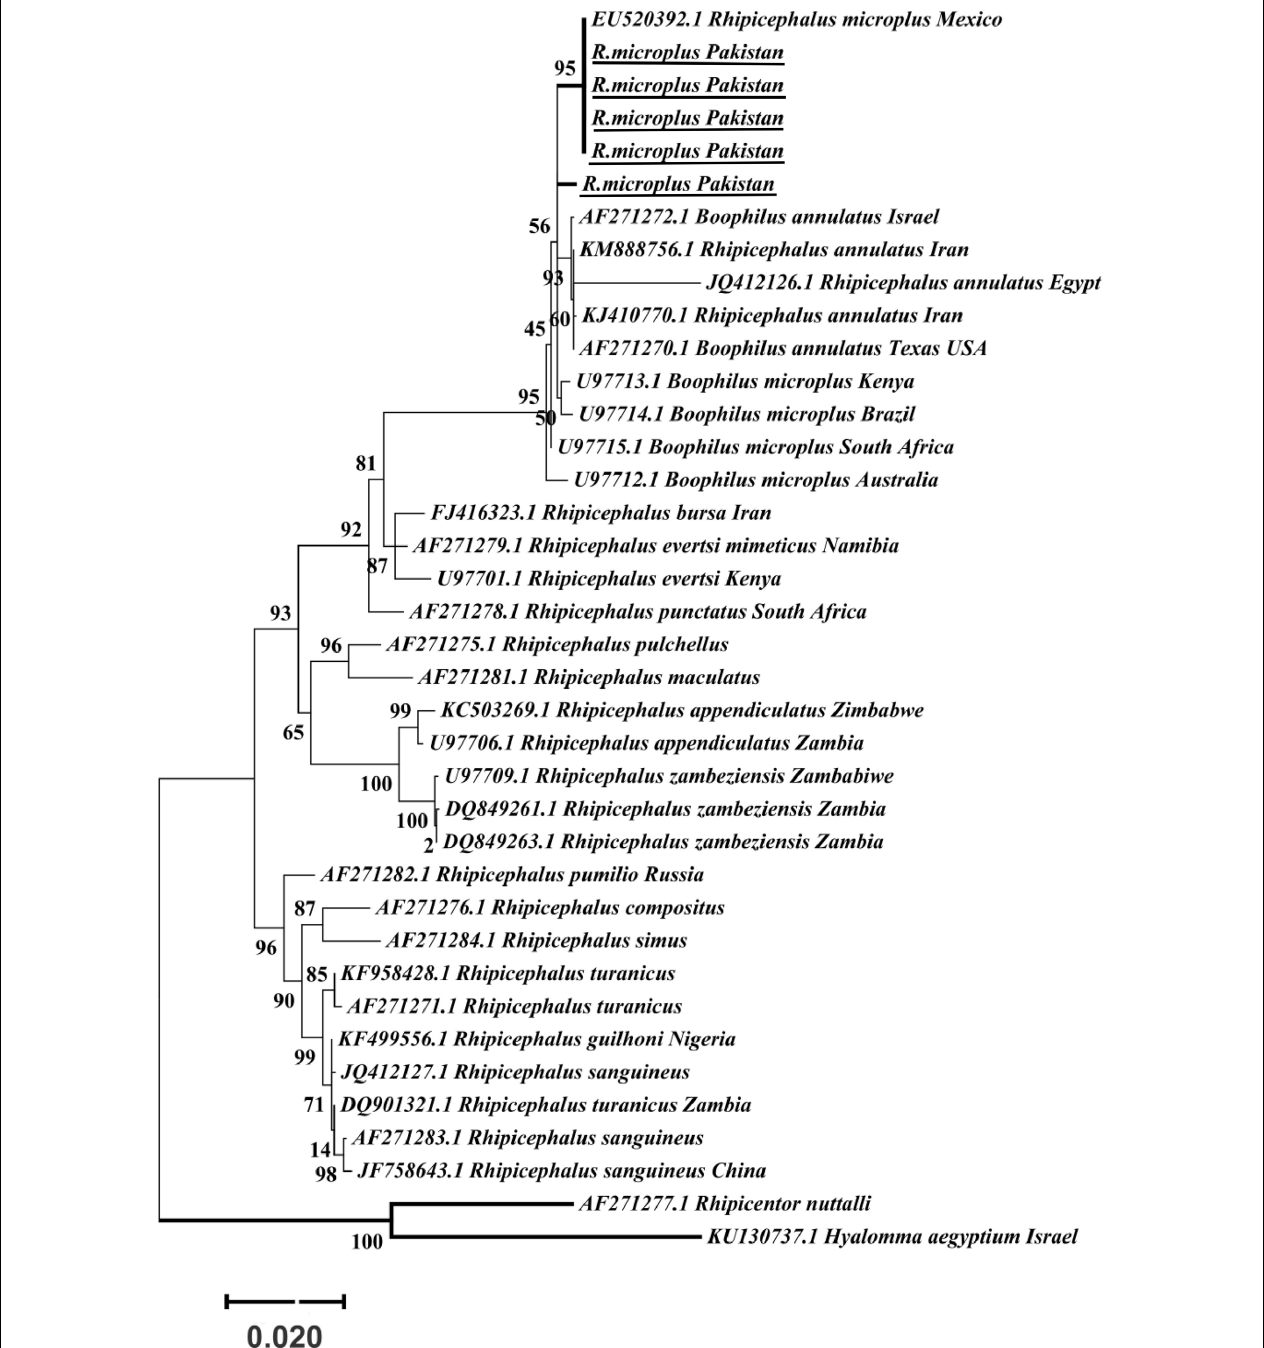
FIGURE 5 | Maximum likelihood tree inferred from ITS2 sequences of the genus Rhipicephalus and using Rhipicentor and Hyalomma sequences as outgrowth. GenBank accession numbers are followed by species name and collection location. Support values (Bootstrapping values) were indicated at each node. The bar represents 0.020 substitutions per site. Sequences obtained in the present study were